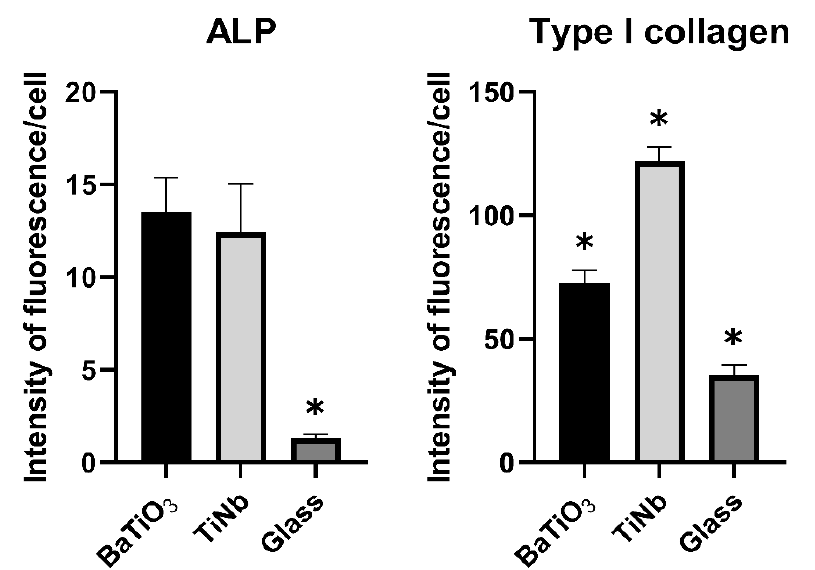
Figure 12. Evaluation of fluorescence intensity of molecules involved in osteogenic cell differentiation, i.e., alkaline phosphatase (ALP) and type I collagen, normalized to the cell number on the Ti39Nb alloy coated with BaTiO 3 (BaTiO 3 ), on bare Ti39Nb alloy (TiNb), and on control microscopic glass coverslips (Glass). Mean + S.E.M. from 16 microphotographs for each experimental group. ANOVA, Student-Newman-Keuls Methods. Asterisks above the columns indicate experimental groups significantly differing ( p ≤ 0.05) from the other groups.